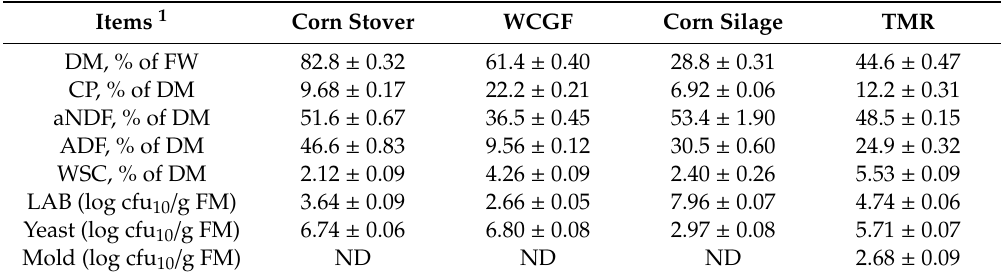
Table 1. Chemical composition and microbial population of fresh materials and total mixed ration before ensiling. (mean ± standard